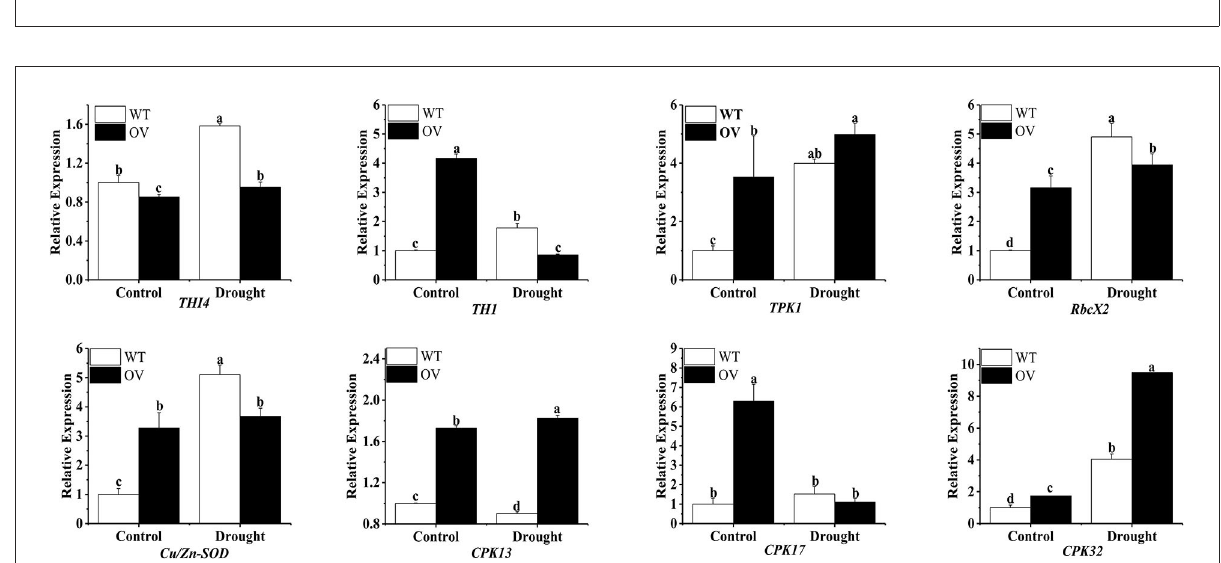
FIGURE6 Expression of eight associated genes in transgenic alfalfa plants with overexpressing MsTHI1 under drought stress. WT, wild-type alfalfa. OV, overexpressing MsTHI1 alfalfa. THI4 , thiazole biosynthetic enzyme THIAMIN4. TH1 , HMP-P kinase/TMP pyrophosphorylase. TPK1 , thiamine pyrophosphokinase. RbcX2 , chaperonin-like RbcX protein 2. Cu/Zn-SOD , superoxide dismutase [Cu-Zn]. CPK13 , CPK17 , and CPK32 : calcium-dependent protein kinases. Mean ± standard deviations from three biological replicates are shown with error bars. These letters denote statistically significant variations ( α =